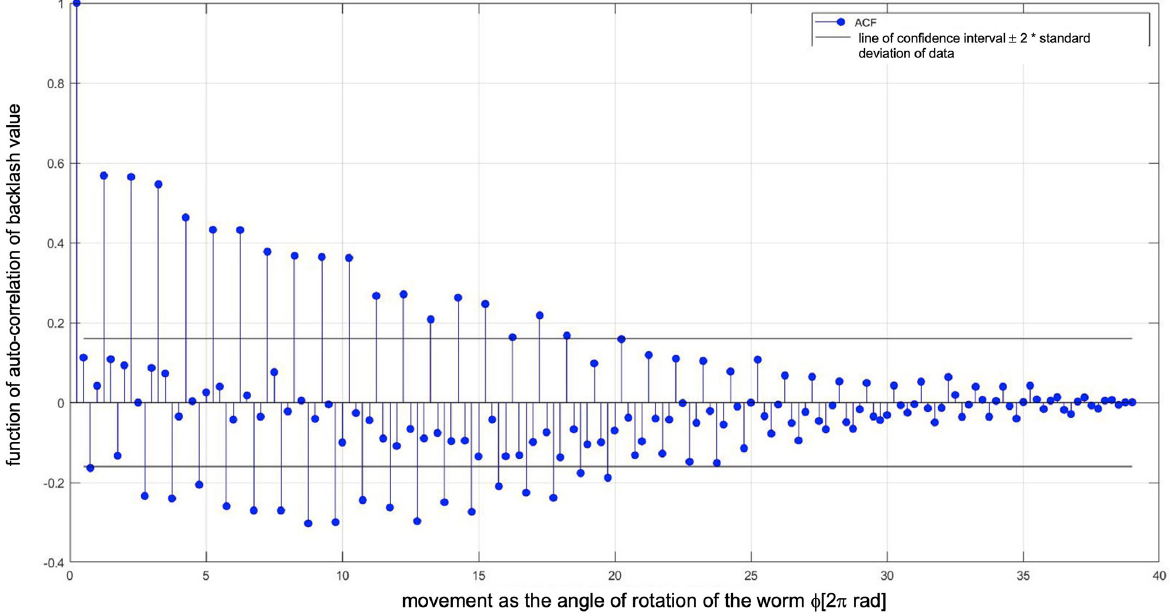
Figure 18. Length of autocorrelation of backlash